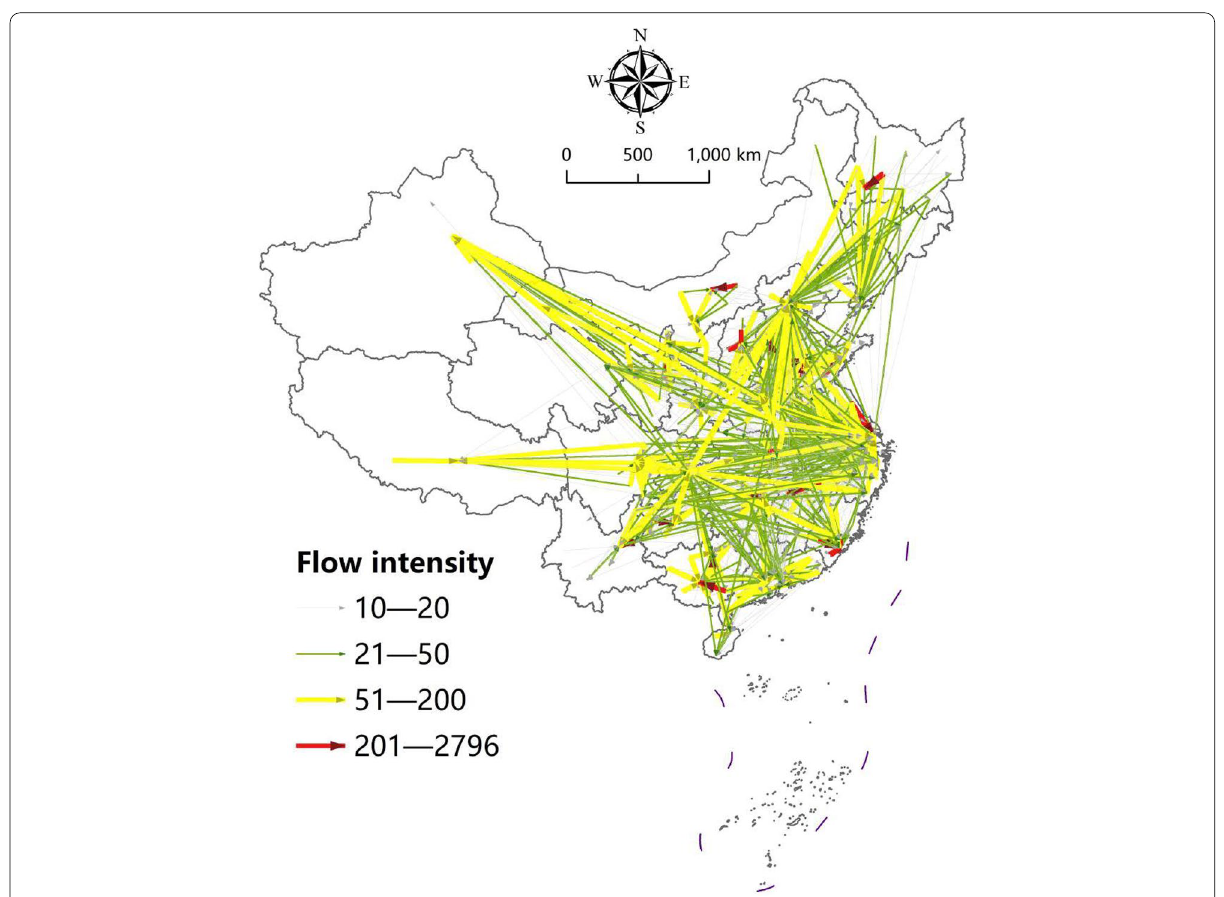
Fig. 2 Migration route and intensity of floating population. Data source: China Migrants Dynamic Survey (CMDS;